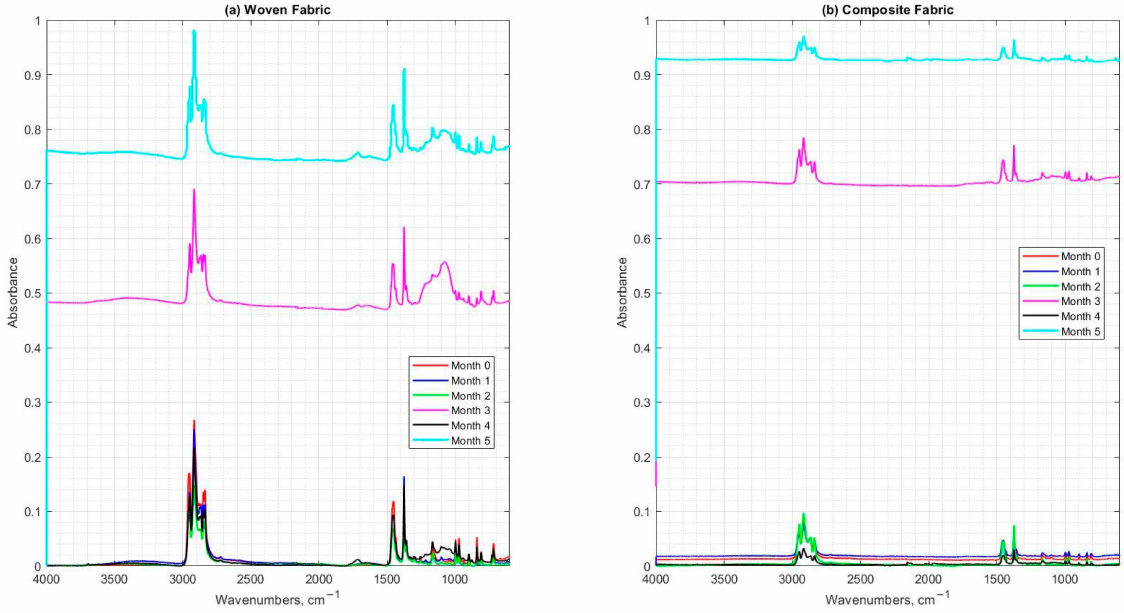
Figure 8. ( a ) FTIR spectra of PP120S fabric under various UV exposure levels; ( b ) FTIR spectra of TC120 fabric under various UV exposure